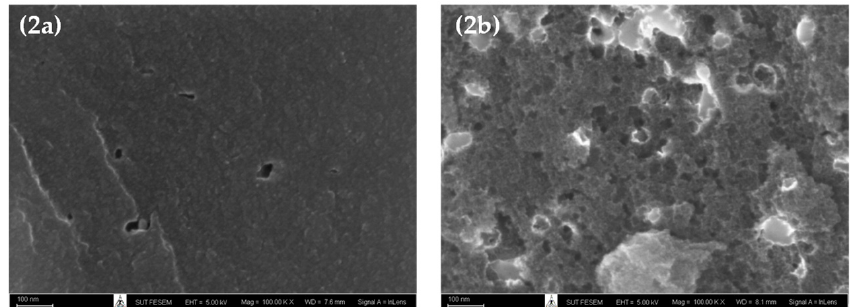
Figure 1. SEM micrographs of ( a ) the microporous-activated carbon of A2 (A850–180), and ( b )